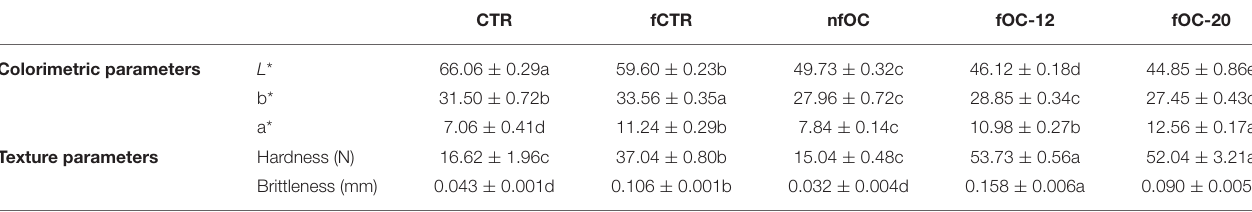
TABLE 4 | Color and texture profile analysis of gluten-free breadsticks.